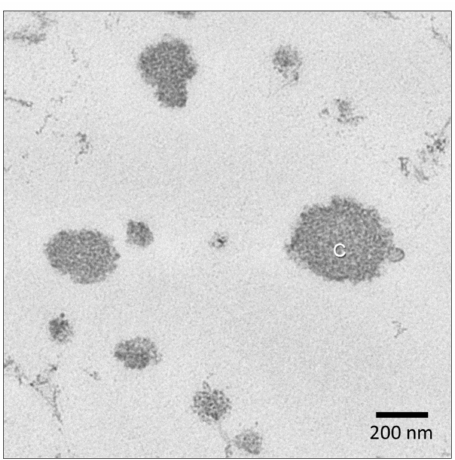
Figure 3. Transmission electron microscopy of casein micelles (C) in raw milk. Sample was prepared as described by D’Incecco et al. 2018